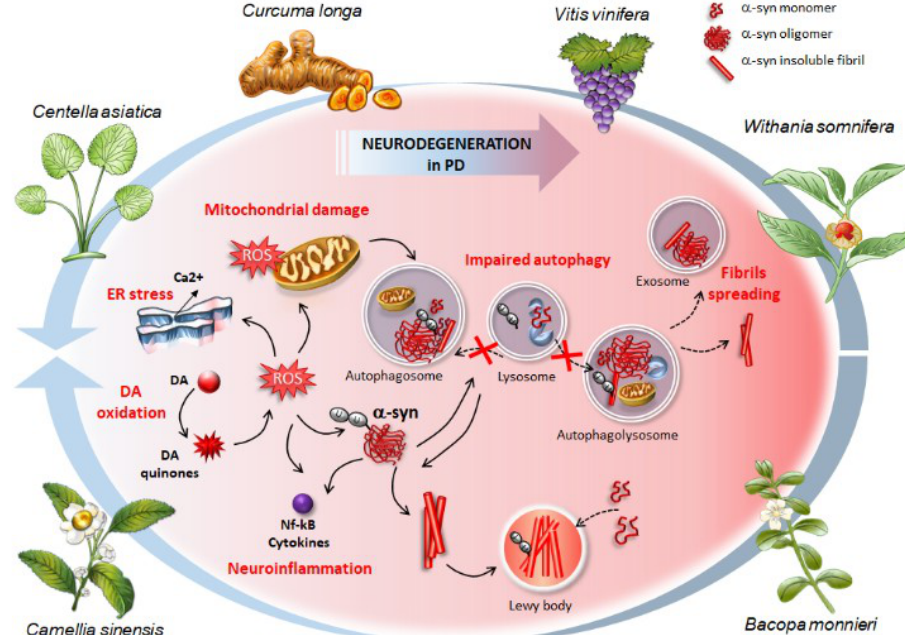
Figure 1. The e ff ects of phytochemical-rich plants in counteracting the cascade (plain black arrows) of molecular events, which occur in synucleinopathies and Parkinson’s disease (PD). These include (i) oxidative stress and accumulation of Reactive Oxygen Species (ROS) arising from altered dopamine (DA) metabolism (DA oxidation), (ii) endoplasmic reticulum (ER) and mitochondrial stress, (iii) structural alterations of α -syn, formation of insoluble aggregates up to Lewy bodies where native α -syn monomers are sequestered (dashed black arrows), (iv) neuroinflammation, and (v) autophagy impairment due to either altered autophagosome biogenesis or impaired fusion between lysosomes and autophagosomes (dashed black arrows). The buildup of ubiquitinated α -syn aggregates contributes to further impairing the autophagy machinery thus fueling a vicious circle where damaged autophagy substrates accumulate due to impaired clearance and turnover. This, in turn, contributes to increasing the overall vulnerability of DA neurons and promoting the spreading of α -syn (dashed black arrows). Phytochemicals from the plants represented here confer neuroprotection by preventing or reverting (blue arrows) this pathological cascade, starting from autophagy induction to inhibition of α -syn aggregation, neuroinflammation, and oxidative